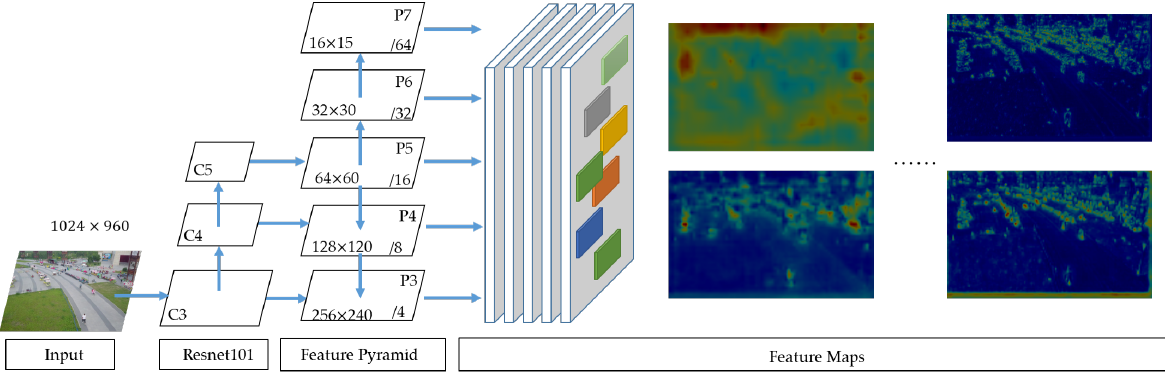
Figure 2. The framework of the feature extracting